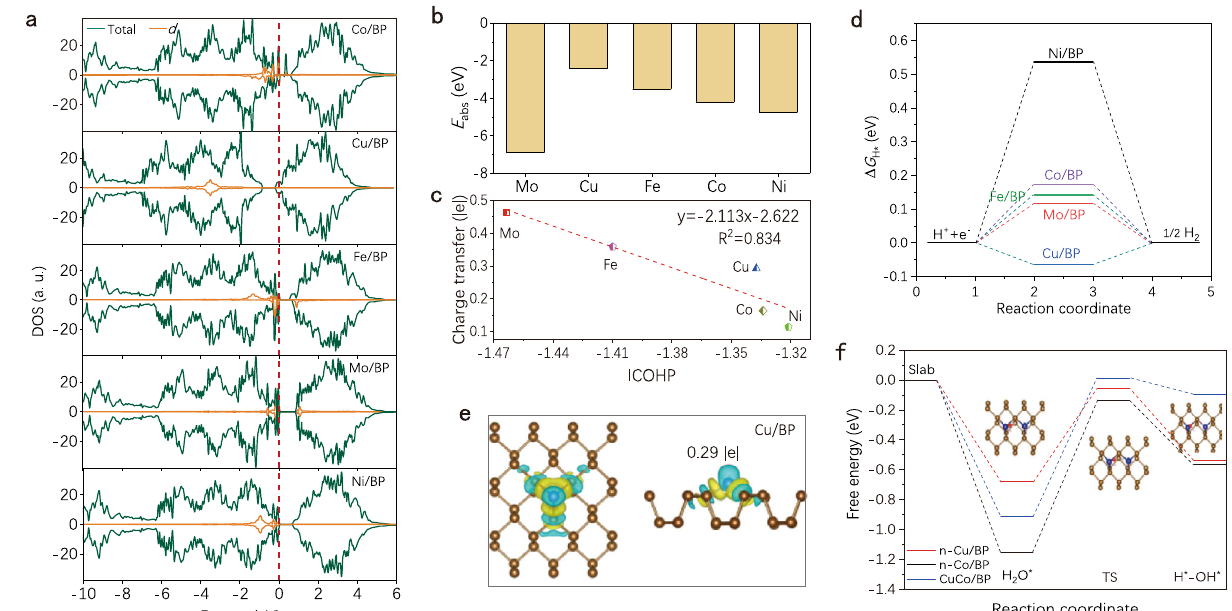
e The charge density difference diagram of Cu/BP and corresponding charge transfer from the Cu atom to the BP layer. Cyan and yellow contours represent electron depletion and accumulation. The isosurface value is 0.002e/Å 3 . f